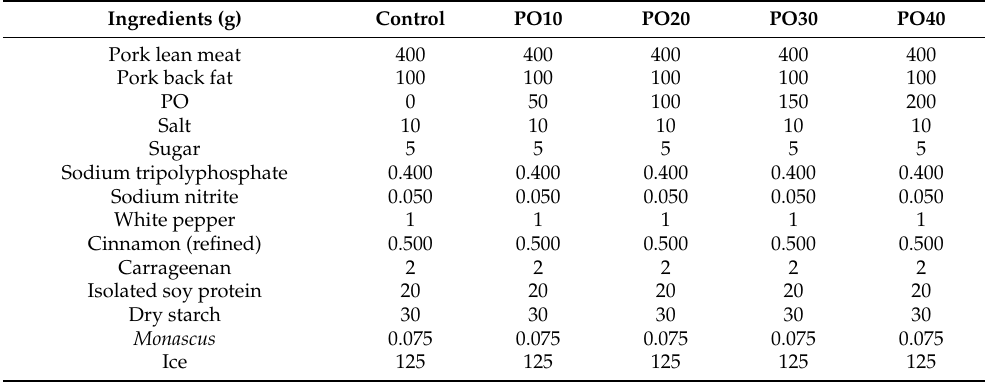
Table 1. Formulations of Pleurotus ostreatus (PO) pork